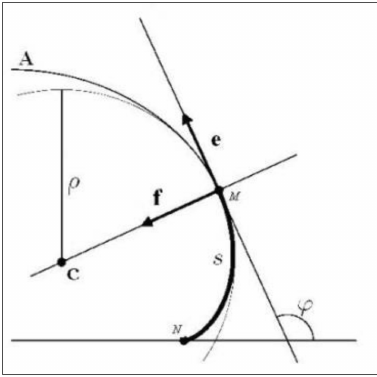
Figure 2. Circle involute